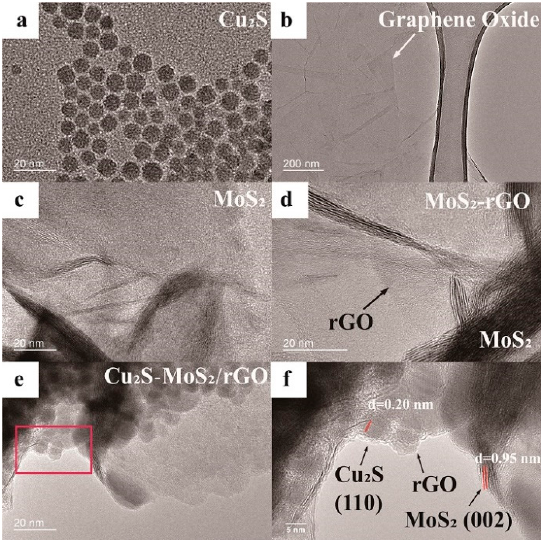
Figure 1. TEM images of ( a ) Cu 2 S, ( b ) graphene oxide, ( c ) MoS 2, ( d ) MoS 2 /rGO, ( e ) Cu 2 S-MoS 2 /rGO, and ( f ) high-resolution TEM images of Cu 2 S-MoS 2 /rGO